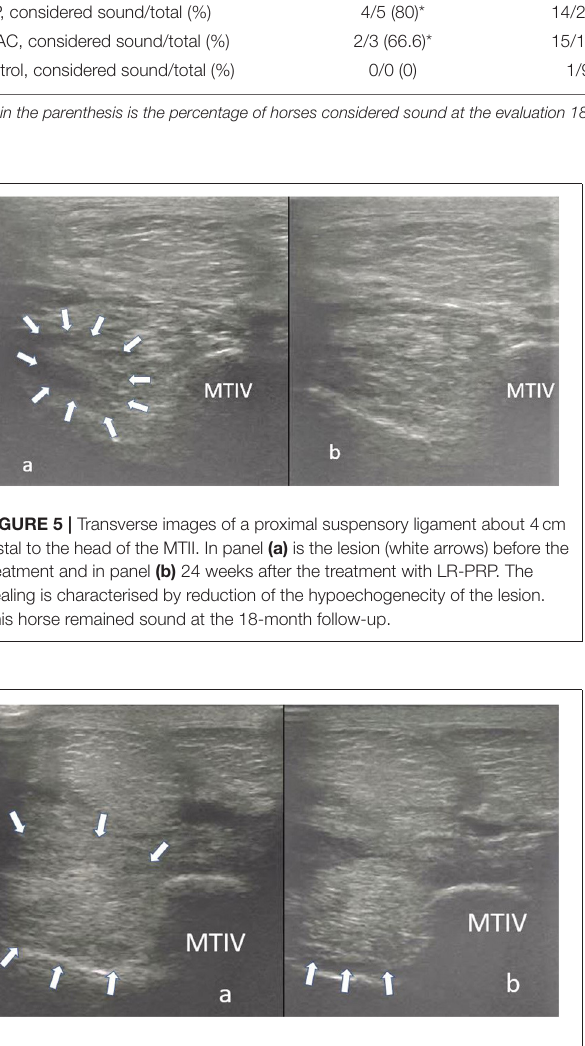
FIGURE 6 | Transverse images of the proximal suspensory ligament about 4cm distal to the head of the MTII. In panel (a) , the ligament appears enlarged with poor demarcation of its dorsal and plantar margins. Additionally, two focal hypoechogenic lesions are present in the dorsal aspect of the ligament. In panel (b) , the suspensory ligament 24 weeks after the treatment with BMAC. There is a re-appearance of the dorsal and plantar margins and reduction of the size of the ligament. Moreover, a remnant of the lesions in dorsal aspect is still visible. Nevertheless, the horse was sound 18 months after the treatment.